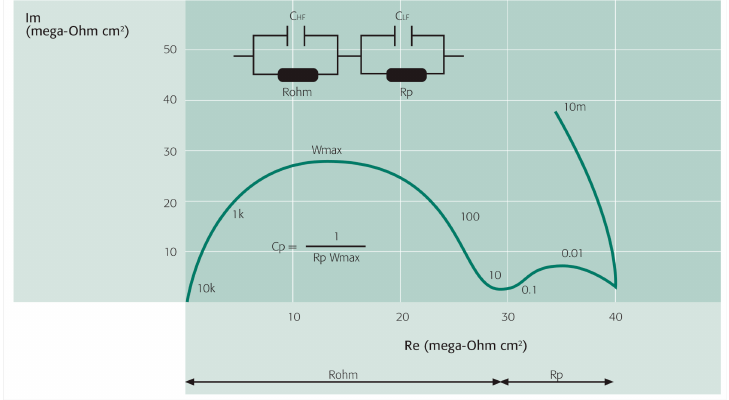
Figure 5. Nyquist diagram of the reactive powder concrete